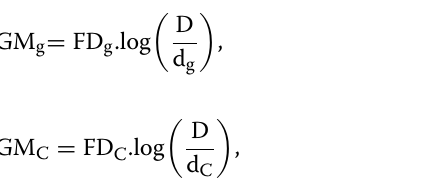
range of the basic granular mixtures and D / d C was the (3) granular range of the granular mixtures of concretes. Fig. 5 shows the variance of the fractal dimension FD values of the basic granular mixtures. Table 5 pro- vides a summary of the data used to identify the basic (4) FGM C granular mixtures (aggregates only) of the concretes as well as the granular concrete mixtures (aggre- gates cement mineral additives) for the fractal + + granular model of all data collected and sorted by the